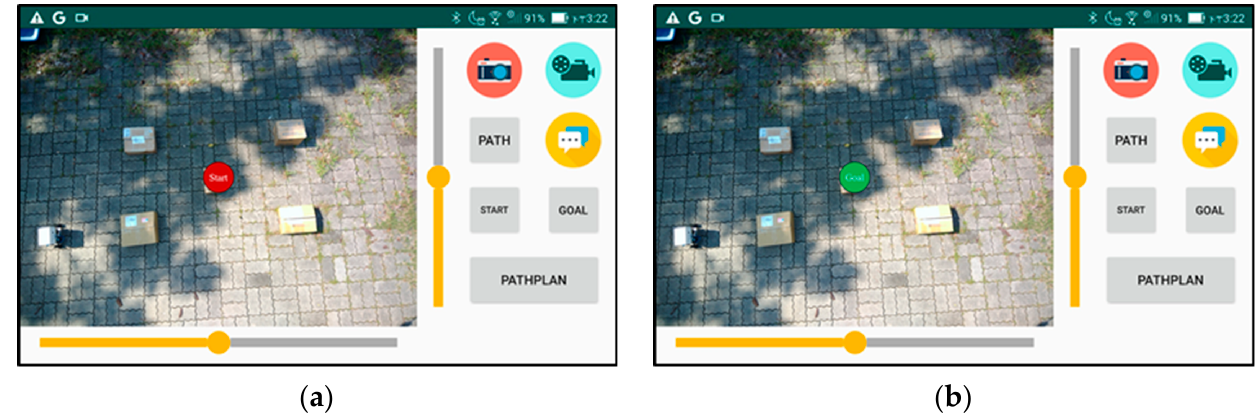
Figure 6. Path planning Interface at UAV.